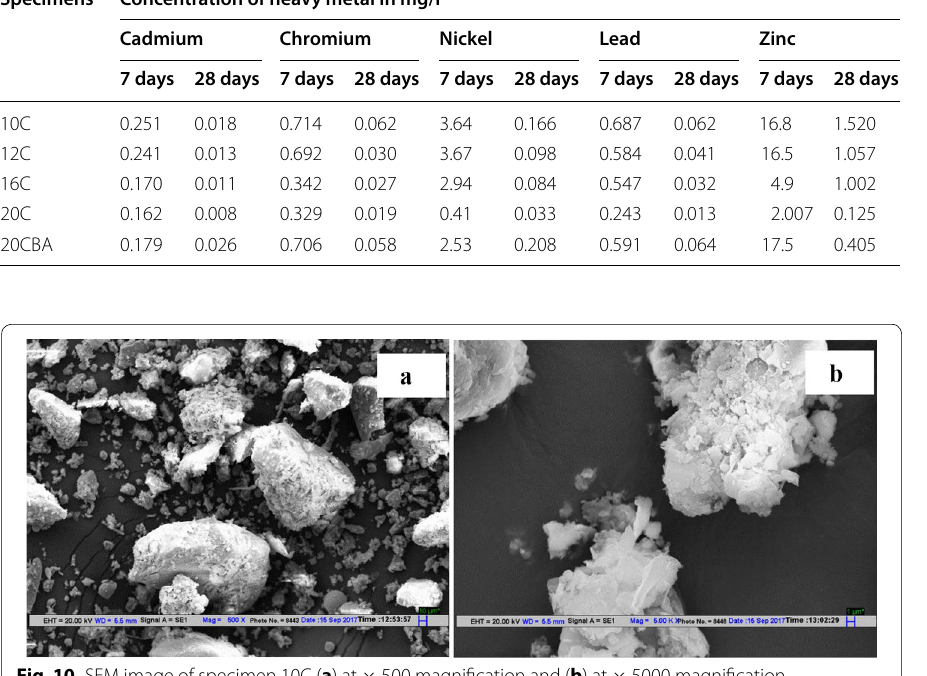
500 magnification and ( b ) at ×